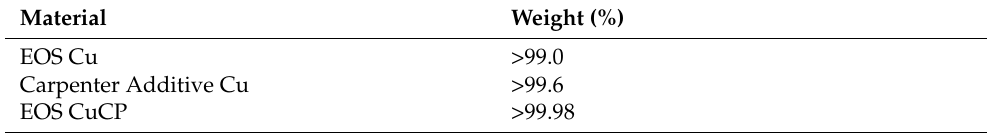
Table 4. High-purity Cu variants and supplier-specified purity.